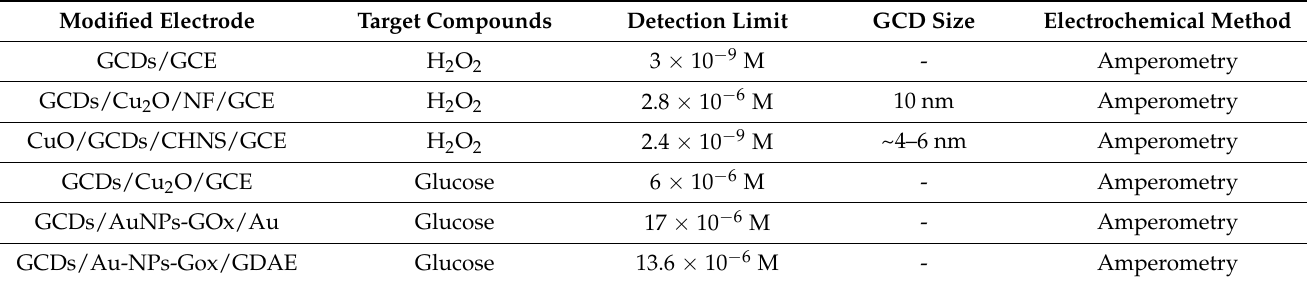
Table 7. H 2 O 2 and glucose detection by GCDs-based electrochemical sensors